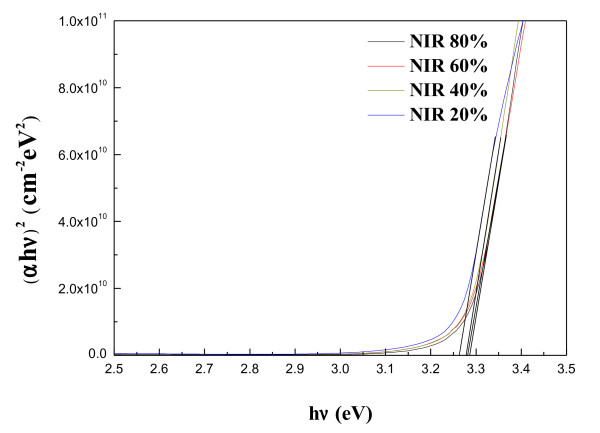
The plot of (αhν)2versus hνfor AZO thin films.